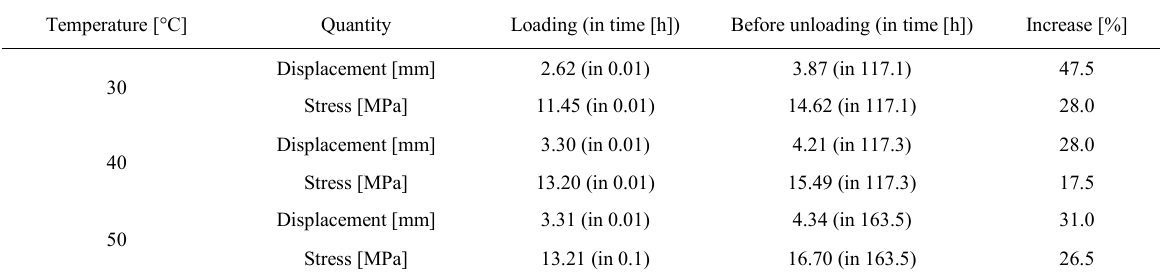
Table 3: Midspan displacement measured by DS I and normal stress measured by SG2 at loading and right before unloading in creep test. Temperature [°C] Quantity Loading (in time [h]) Before unloading (in time